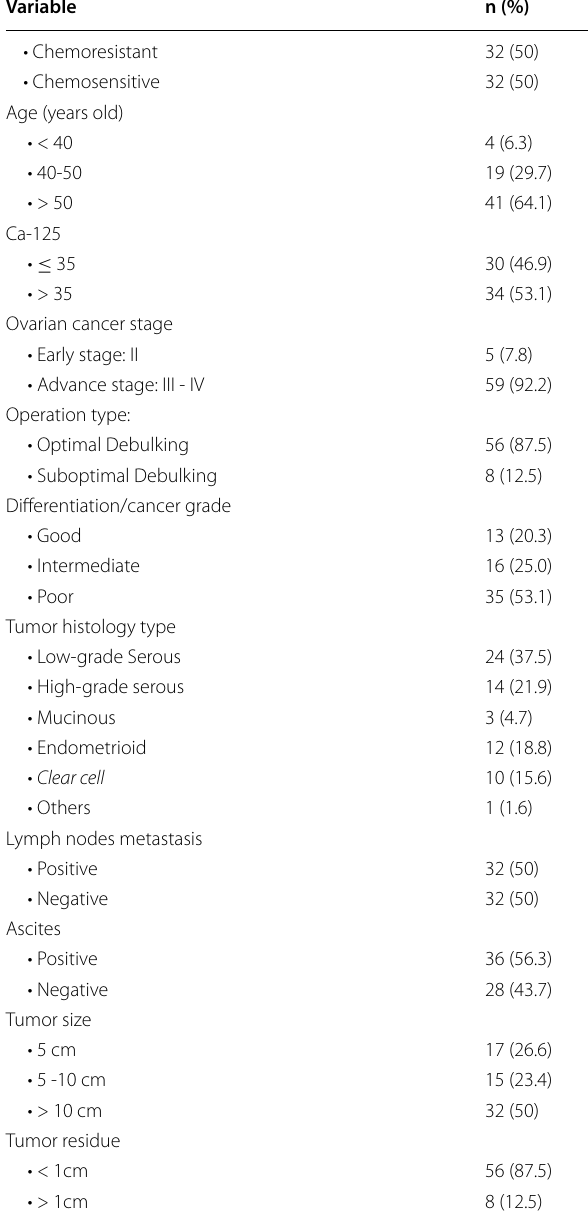
Table 1 Basic patients’